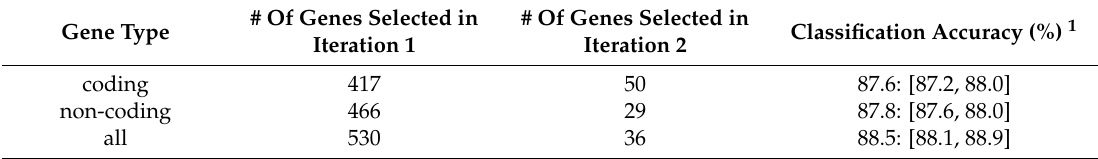
Table 2. Evaluation of the prediction accuracies from TCGA RNAseq ( n = 839) selected genes by two-iteration